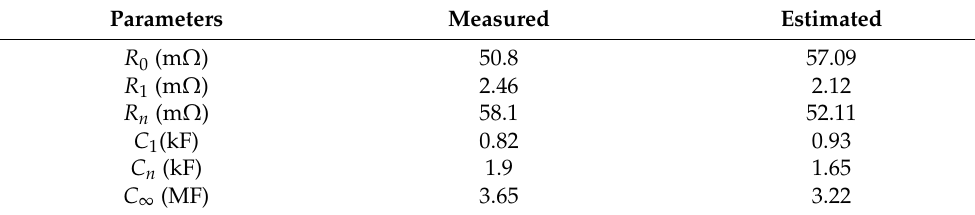
Table 10. Results of Case 3.